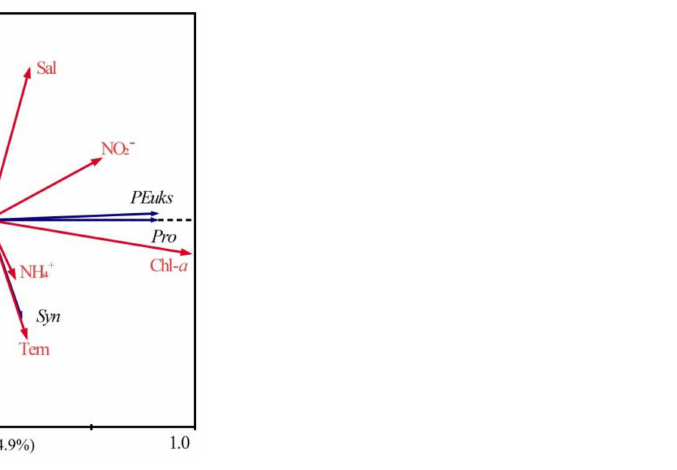
Figure 8. RDA (redundancy analysis) biplots between the response variables and explanatory variables. Synechococcus ( Syn ), Prochlorococcus ( Pro ), Picoeukaryotes ( PEuks ), Nitrate (NO 3 − ), Nitrite (NO 2 − ), Ammonium (NH 4+ ), Phosphate (PO 4- ), Silicate (SIO 32- ), Depth (Dep), Temperature (Tem), Salinity (Sal), Chlorophyll a (Chl- a ).